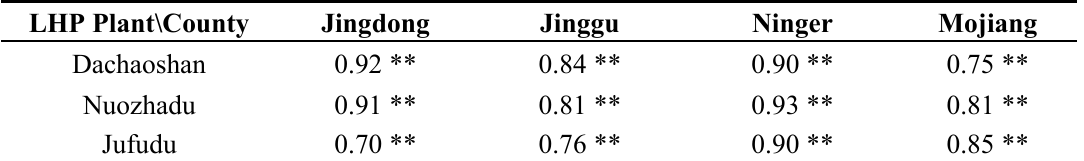
Table 2. The correlation coefficients between SHP plants in a county and the LHP plant.